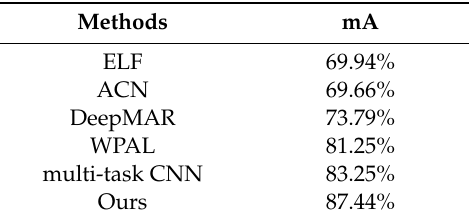
Table 4. Comparison results of di ff erent methods on the RAP dataset.